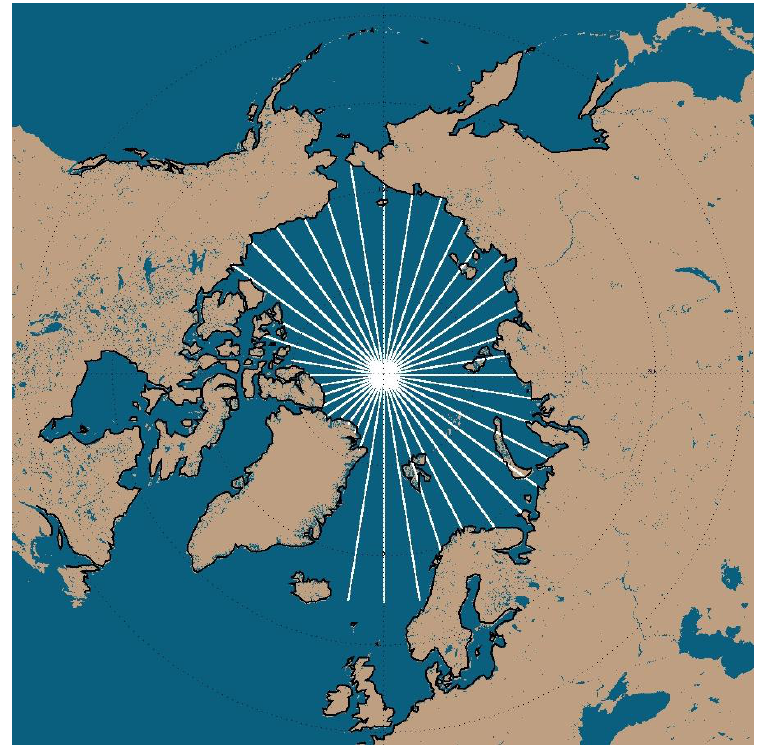
Figure 3. Lines of longitude for ice edge determination.